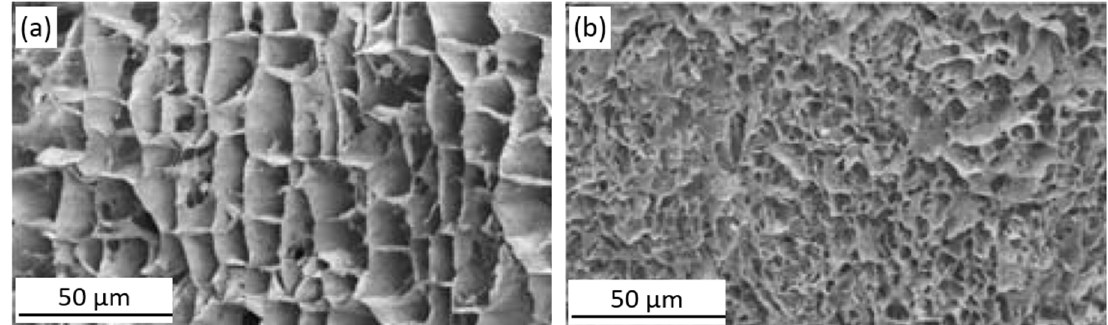
Figure 14. FE‐SEM micrographs of the cryo‐fractured surface of the CNF foams with a density  of Figure 14. FE-SEM micrographs of the cryo-fractured surface of the CNF foams with a density ρ of ( a ) 7 kg m −3 and ( b ) 61 kg m −3 . Note that these foams were prepared by direct quenching at a freezing ( a ) 7 kg m − 3 and ( b ) 61 kg m − 3 . Note that these foams were prepared by direct quenching at a freezing temperature of −196 °C. (Adapted from Sehaqui et al. [40] with permission from the Royal Society of temperature of − 196 ◦ C. (Adapted from Sehaqui et al. [40] with permission from the Royal Society of Chemistry).